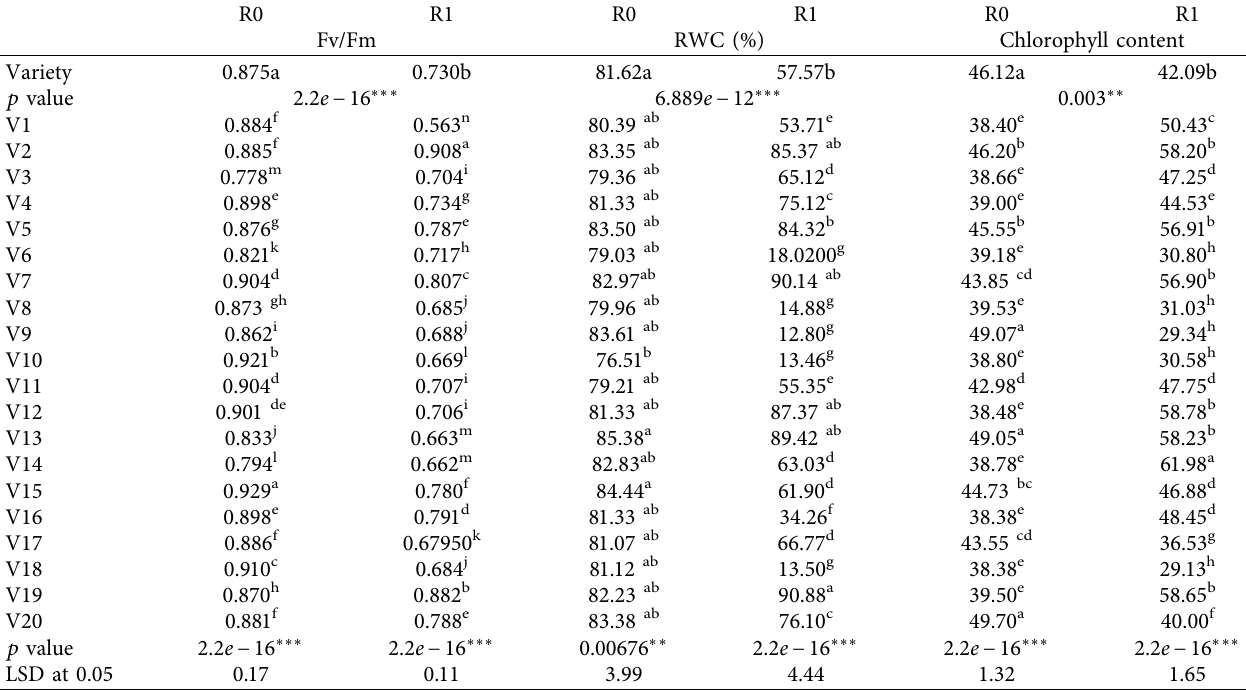
Table 1: Average physiological parameters under drought stress at vegetative